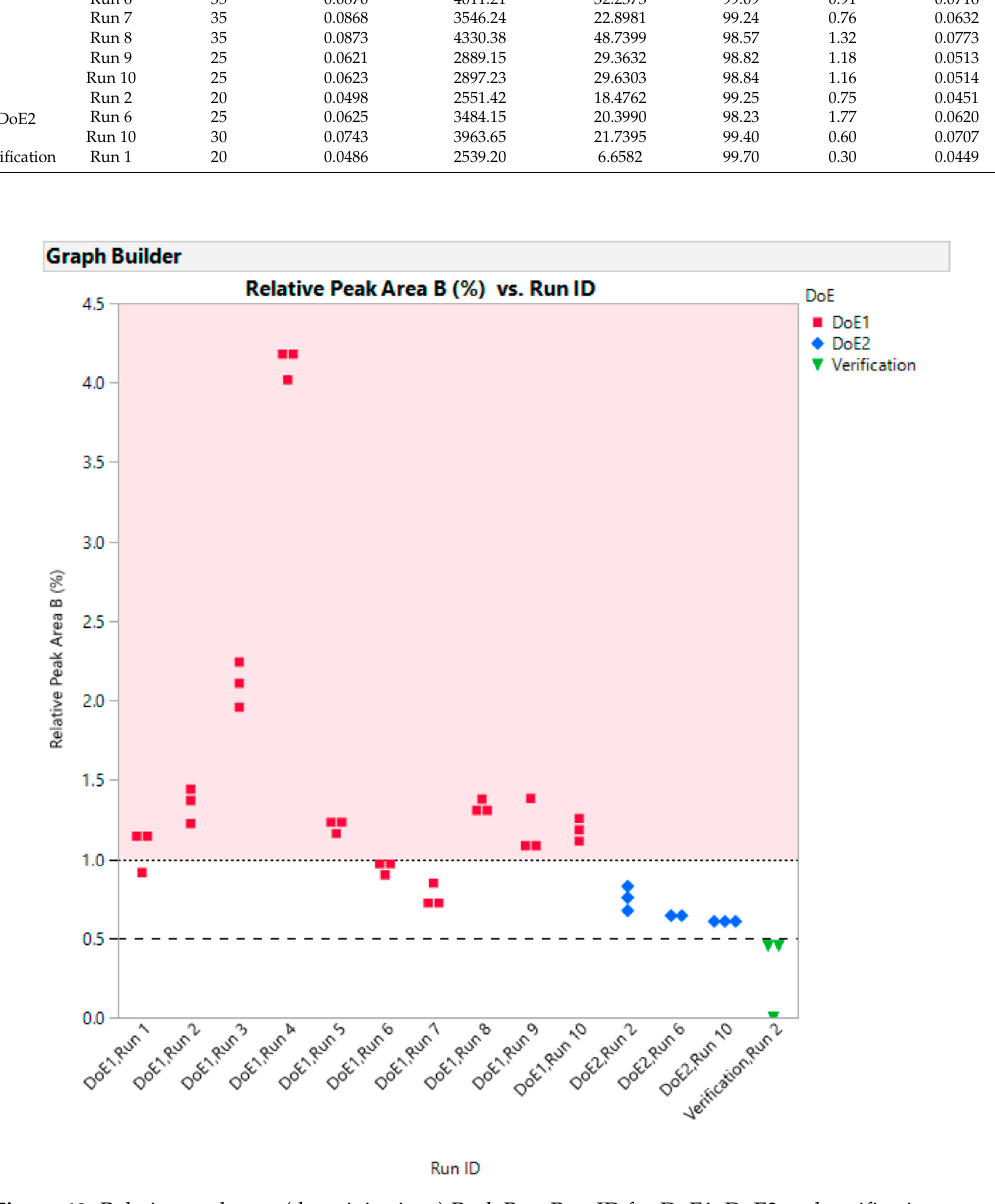
Figure 13. Relative peak area (three injections) Peak B vs Run ID for DoE1, DoE2 and verification runs. A DoE model fitted to the HPLC data (Table 9 and Figure 14) indicates a good model explaining Table 9. Analysis of variance for response relative to peak area B (%). ca.94% of the variation. Die temperature has the most important impact on the relative area of Peak